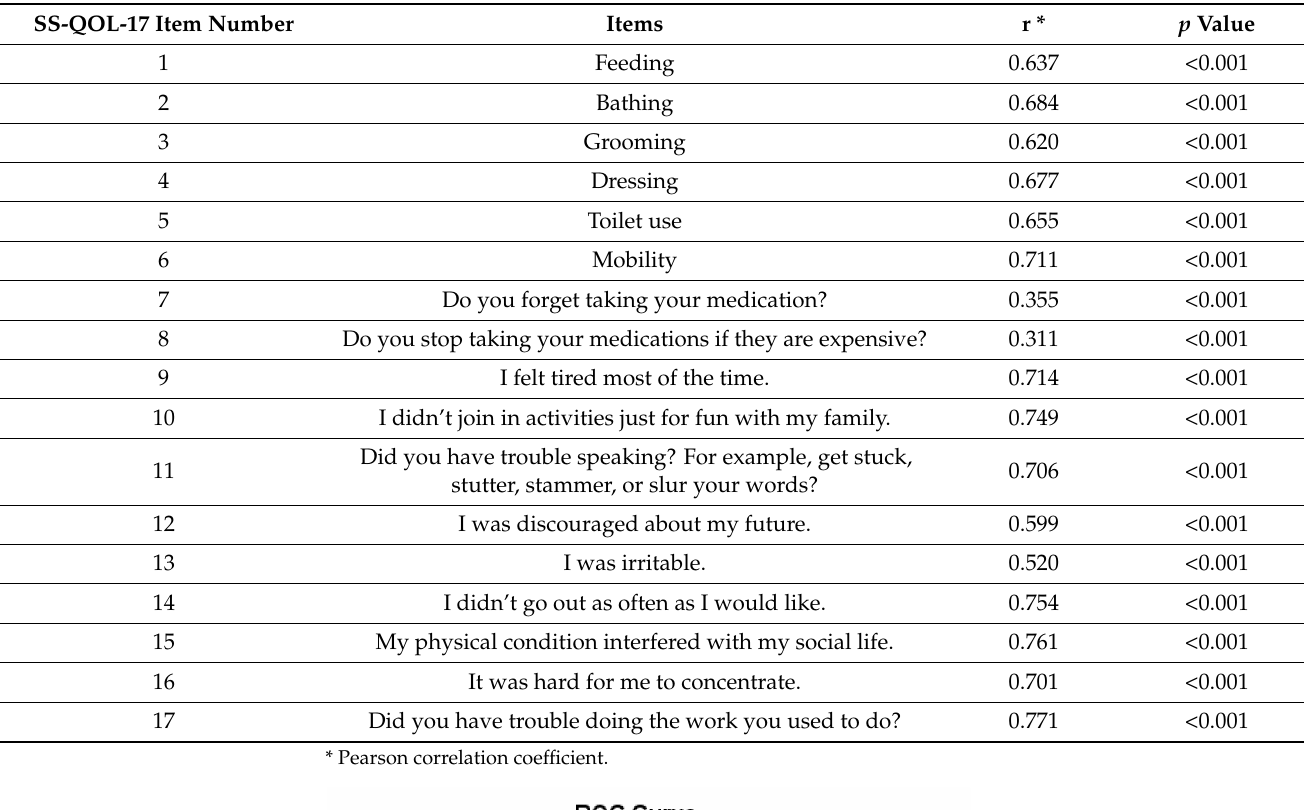
Table 4. Pearson correlation of the SS-QOL-17 items with the full scale among stroke survivors.